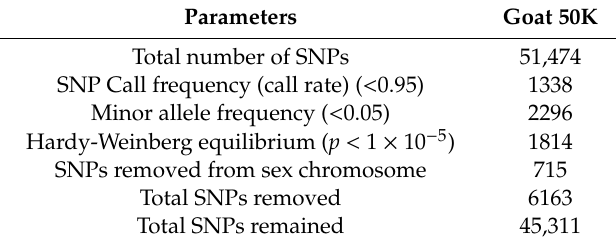
Table 1. Single nucleotide polymorphisms (SNPs) filtration